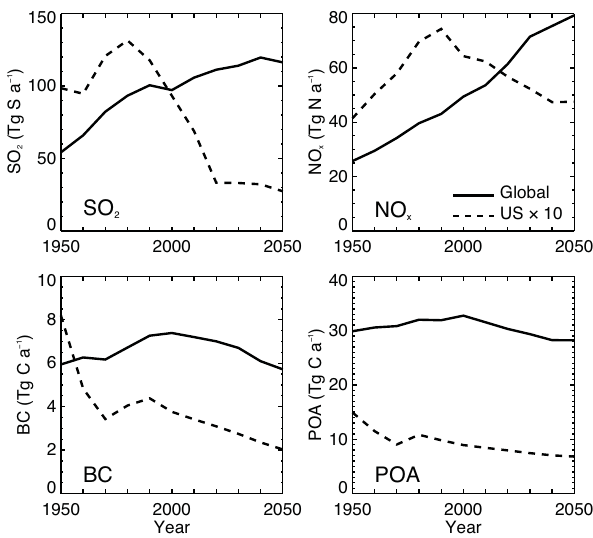
Fig. 1. Global (solid) and US (dashed) trends in emissions of SO 2 , NO x , BC, and POA for 1950–2050. US emissions are multiplied by 10 to fit on scale. SO 2 and NO x emissions are from EDGAR (van Aardenne et al., 2001; Olivier and Berdowski, 2001). BC and POA emissions are from Bond et al. (2007). All emissions are extended past the year 2000 following the IPCC A1B